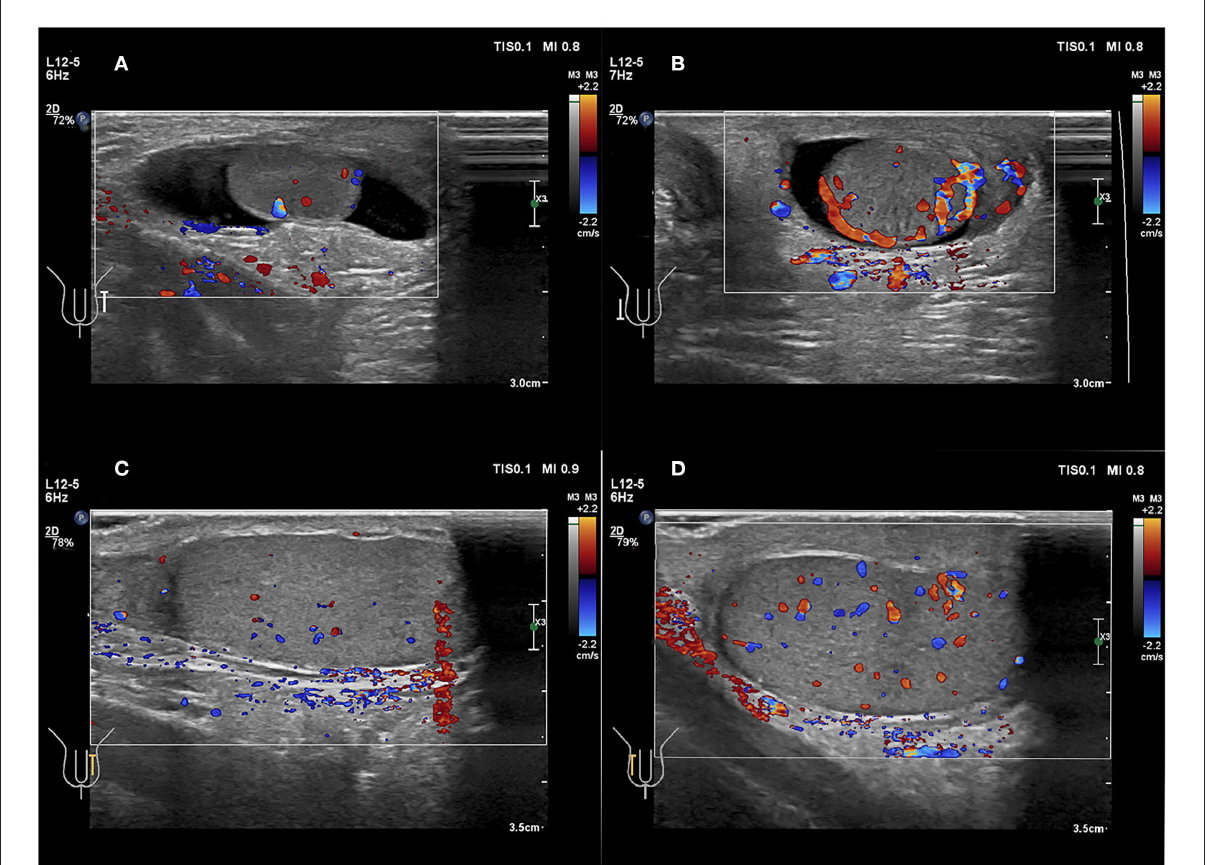
FIGURE6 (A,B) A 49 days old boy with a first episode of acute right scrotal swelling for 4 days. (C,D) A 14 years 3-month-old boy with a first episode of acute right scrotal swelling for 7h. (A,C) Normal testicle, Color Doppler showed blood flow of the testicle was normal. (B,D) Testicular torsion, testicular Color Doppler showed blood flow of the testicle was slightly increased.